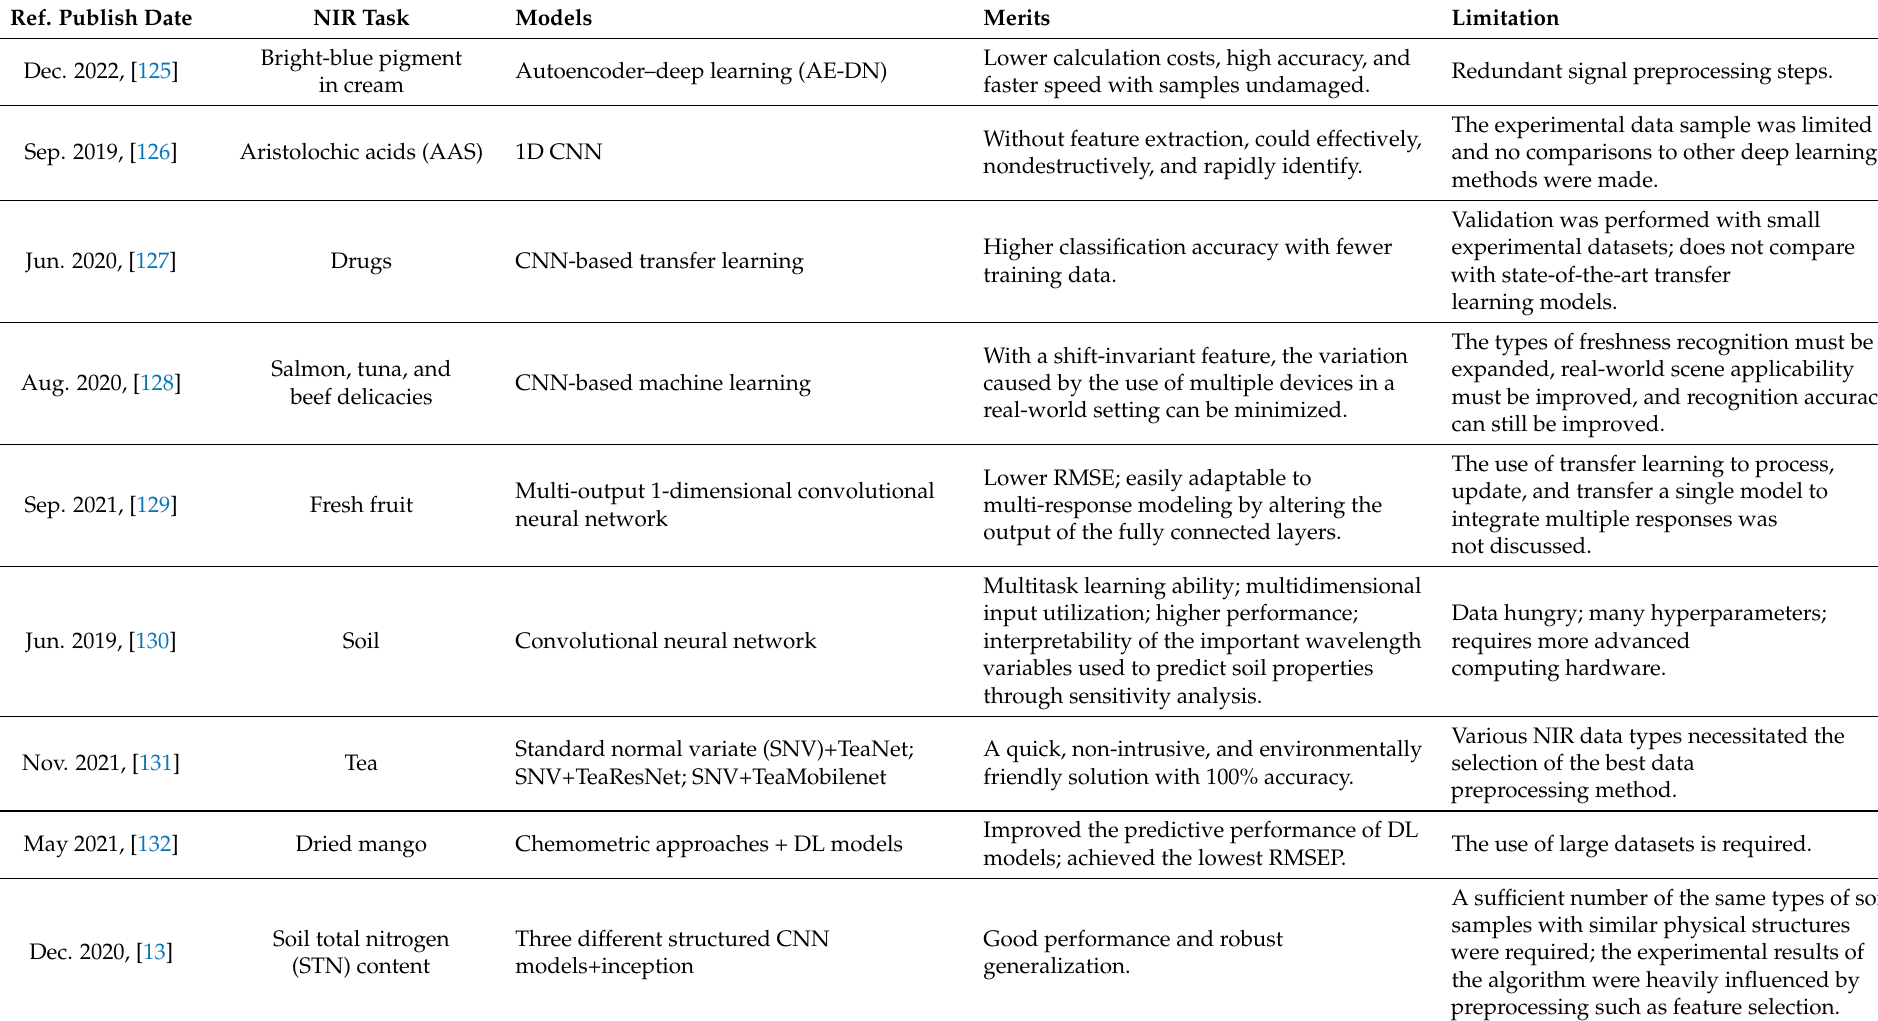
Table 3. Summary of deep architectures used in